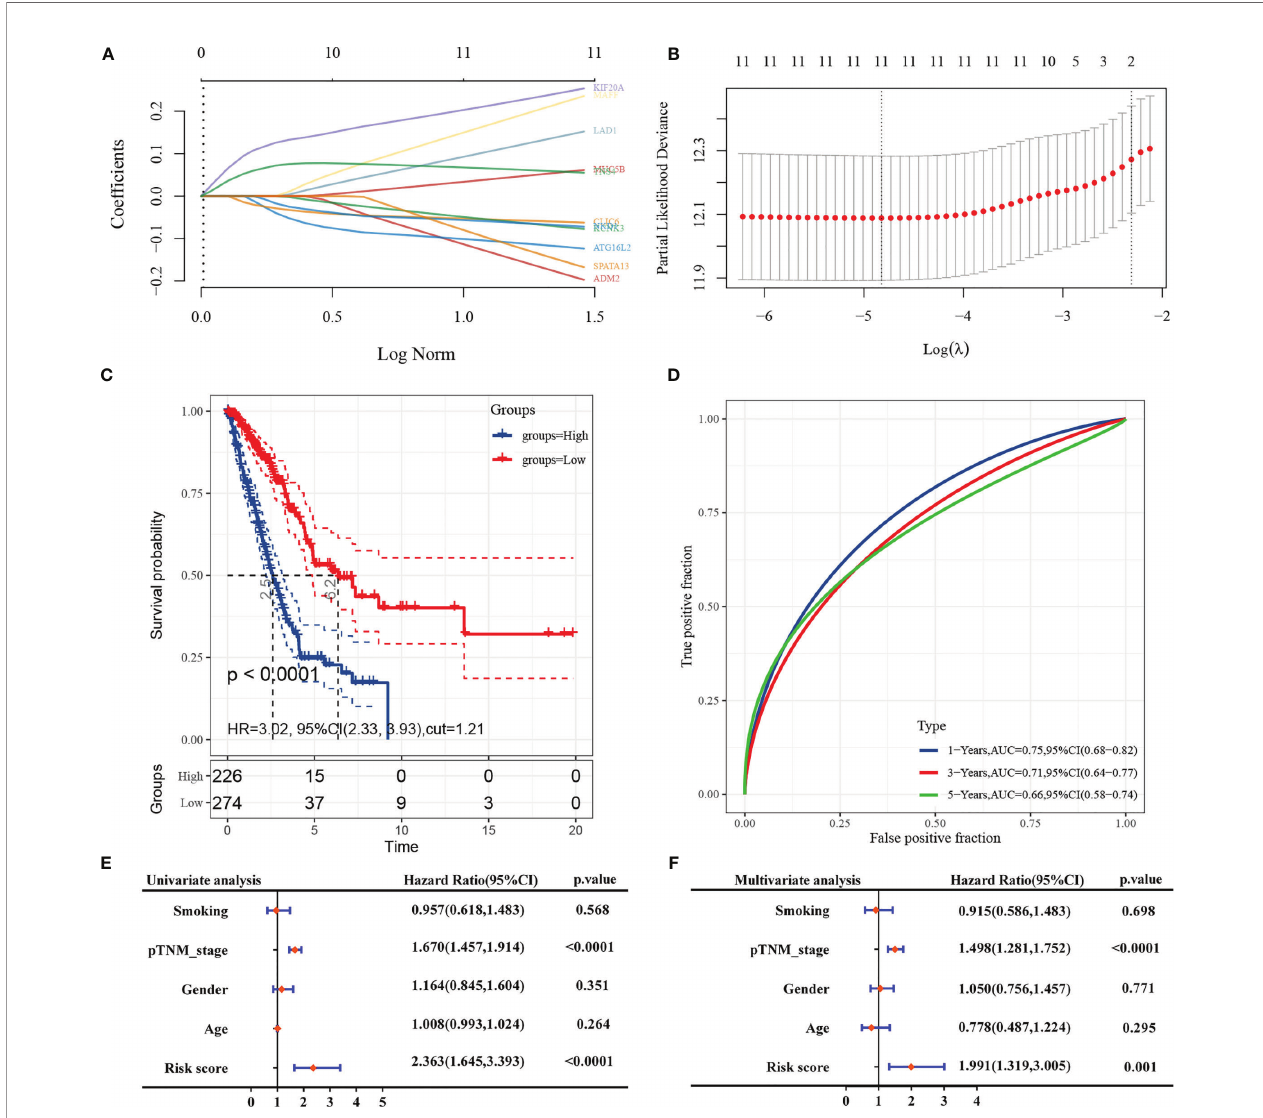
FIGURE 6 | LASSO construction prediction model and COX analysis. ( A : coef fi cients of selected characteristics shown by lambda parameters; B : partial likelihood deviation versus log( l ); C : KM curves for risk grouping; D : ROC curves for this risk prediction model; E : forest plot for univariate COX regression; F : forest plot for multifactor COX